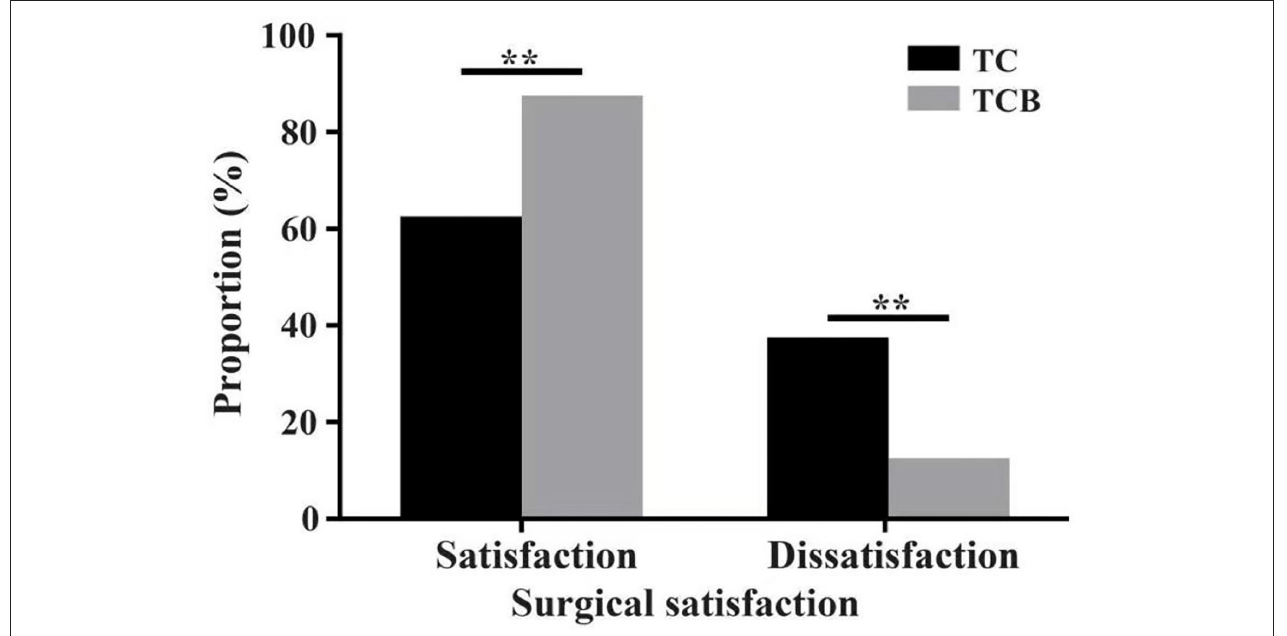
FIGURE 5 | The proportion of cytoreductive surgical satisfaction after TC and TCB treatment in advanced ovarian cancer. * P < 0.0001, vs. control group. **represents P < 0.01.